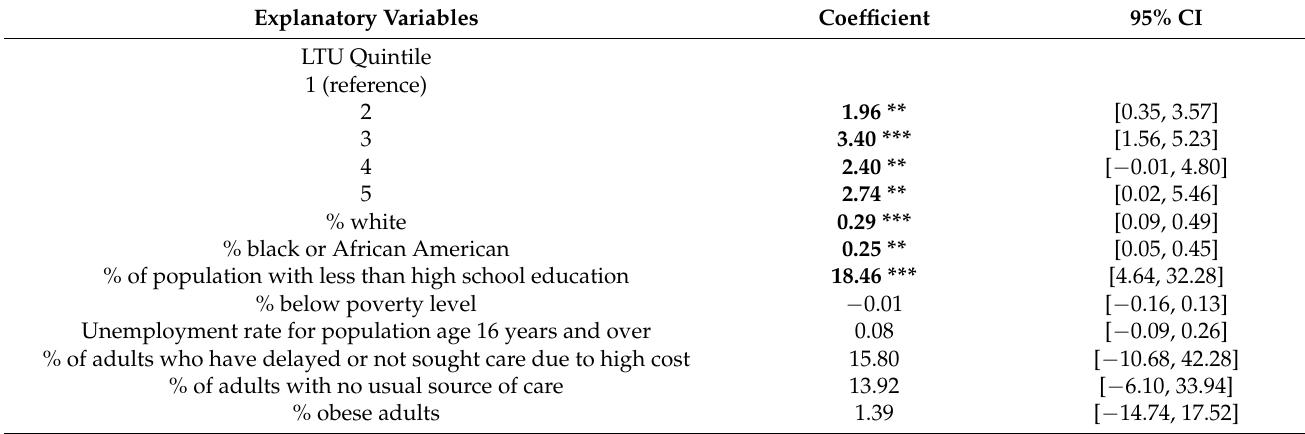
Table 2. Regression Results for Abdominal Pain (ED Visit Rates as the Dependent Variable), South Carolina